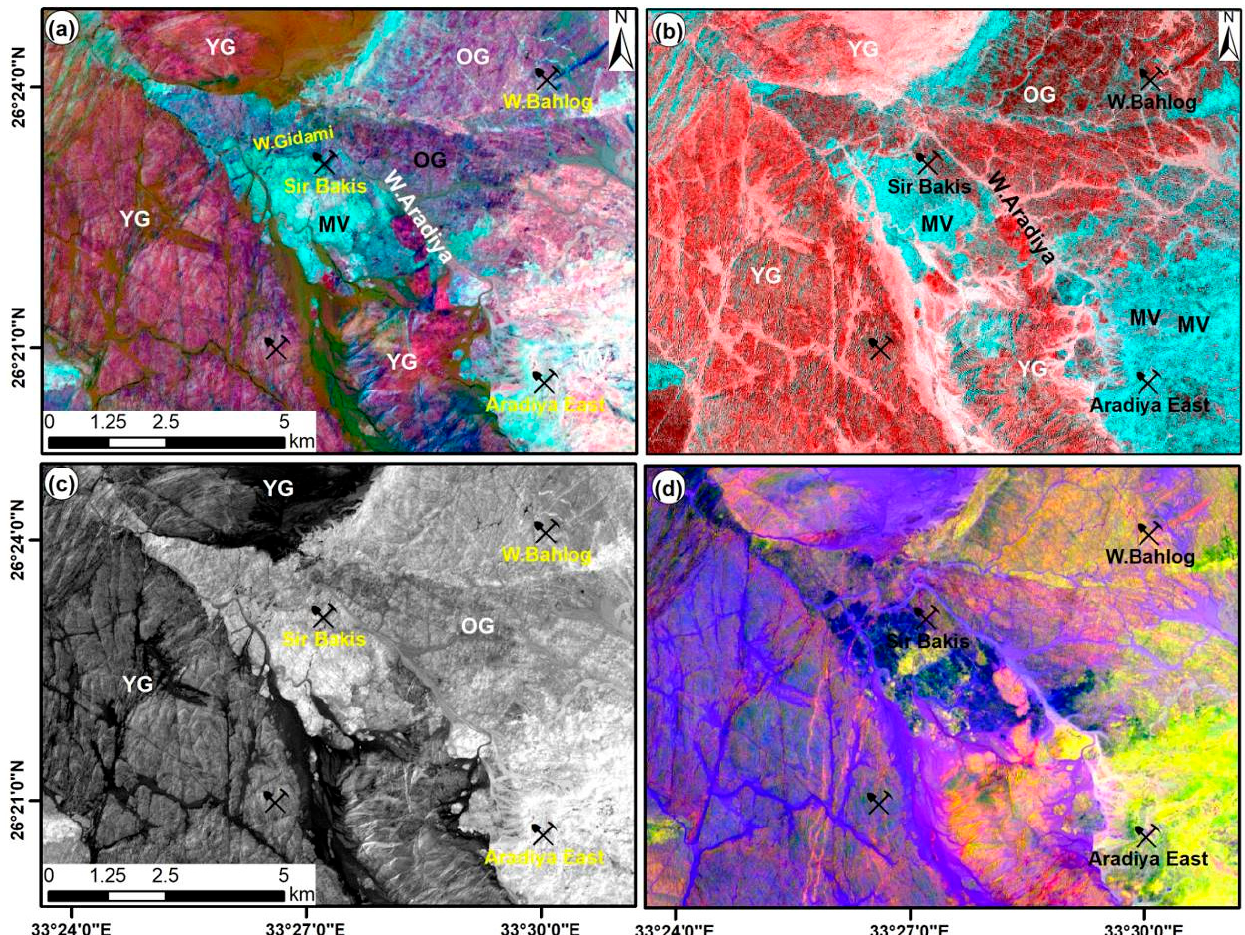
Figure 3. Sentinel-2 ( a ) band ratio composite 12/11, 4/8 and 3/4 in R, G, and B; ( b ) (6/1, 6/8A and (6 + 7)/8A [39]; ( c ) band ratio 3/4; ( d ) band ratio combination 11/8A, (12/8A) + (3/4), and band 3. Table 1. PCA analysis of selected Landsat-8 OLI